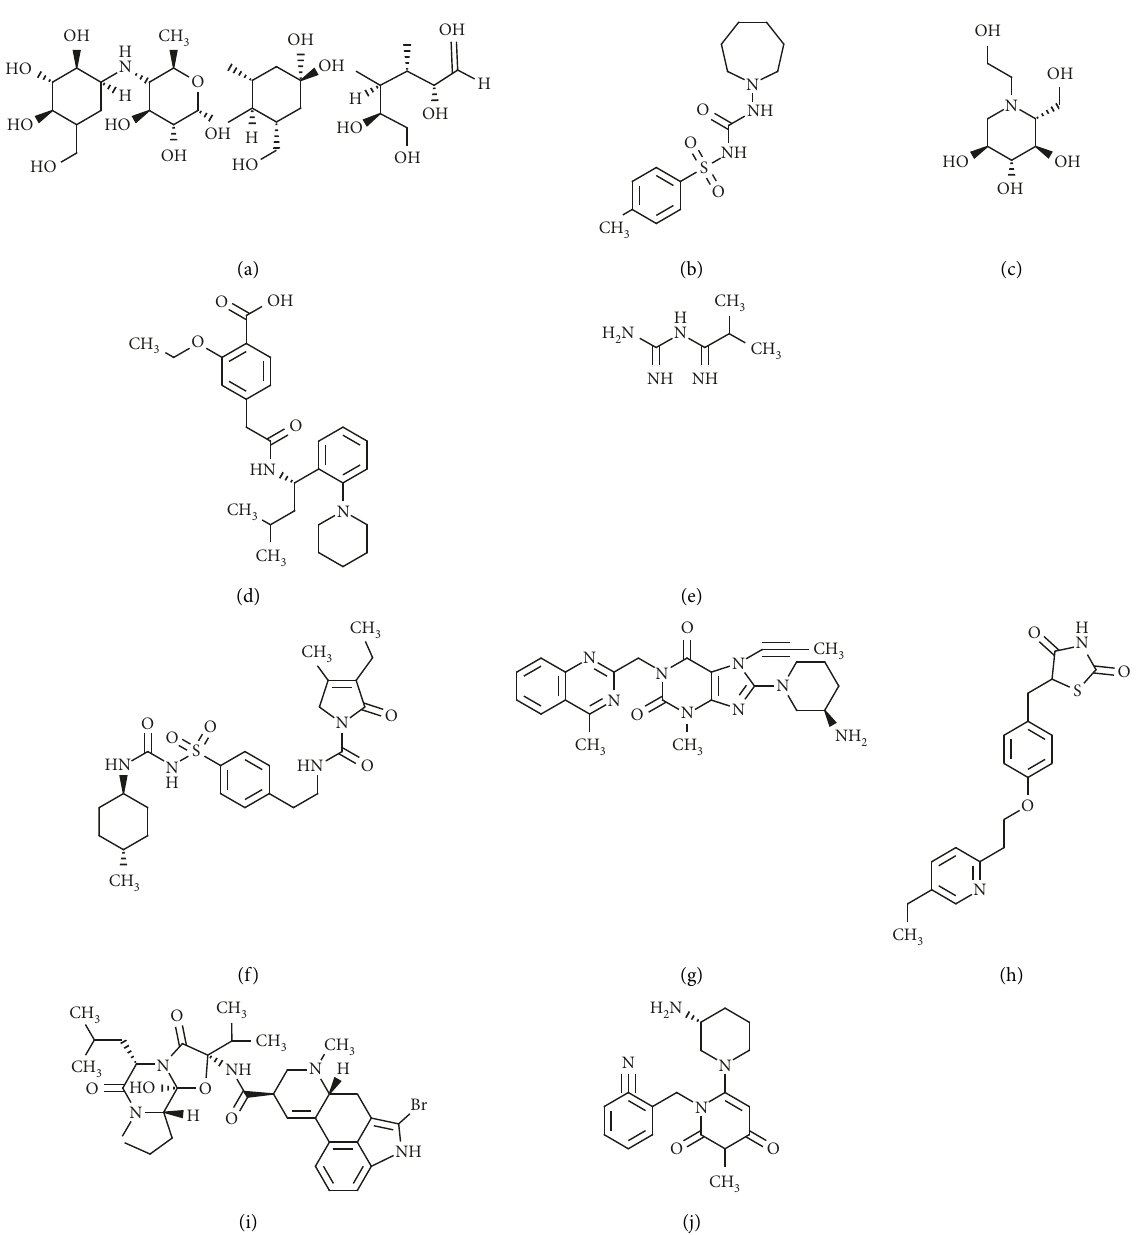
Figure 1: Molecular structure of drugs. (a) Acarbose. (b) Tolazamide. (c) Miglitol. (d) Prandin. (e) Metformin. (f) Glimepiride. (g) Linagliptin. (h) Pioglitazone. (i) Bromocriptine. (j)